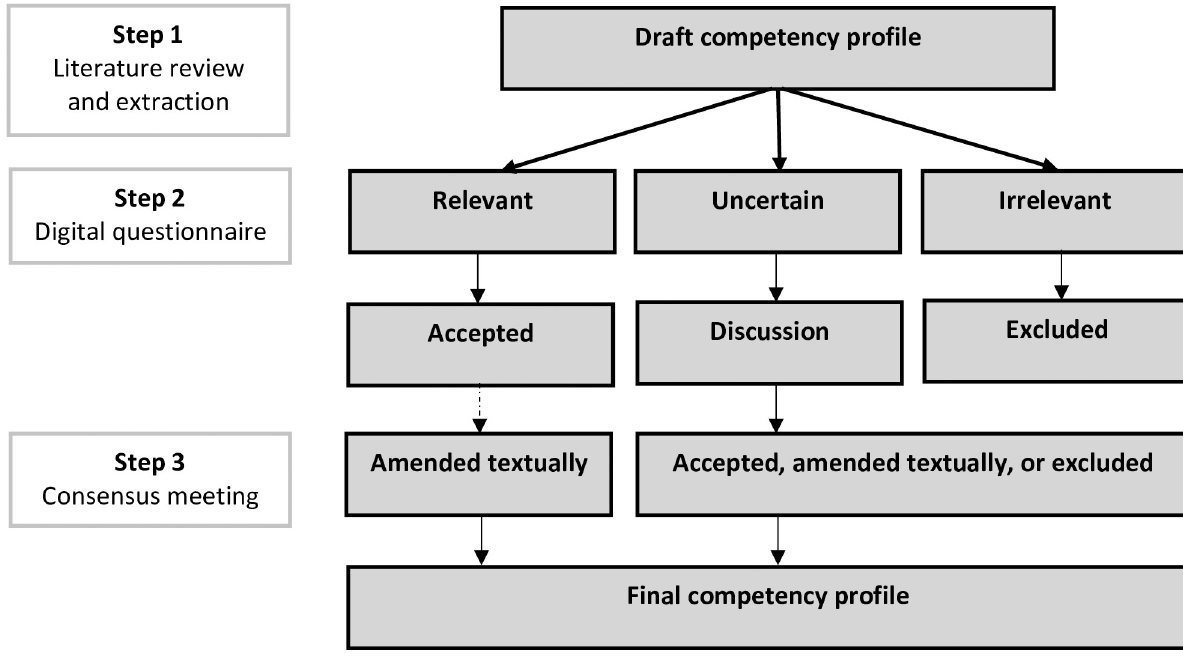
Fig 1. The application of the RAND modified Delphi